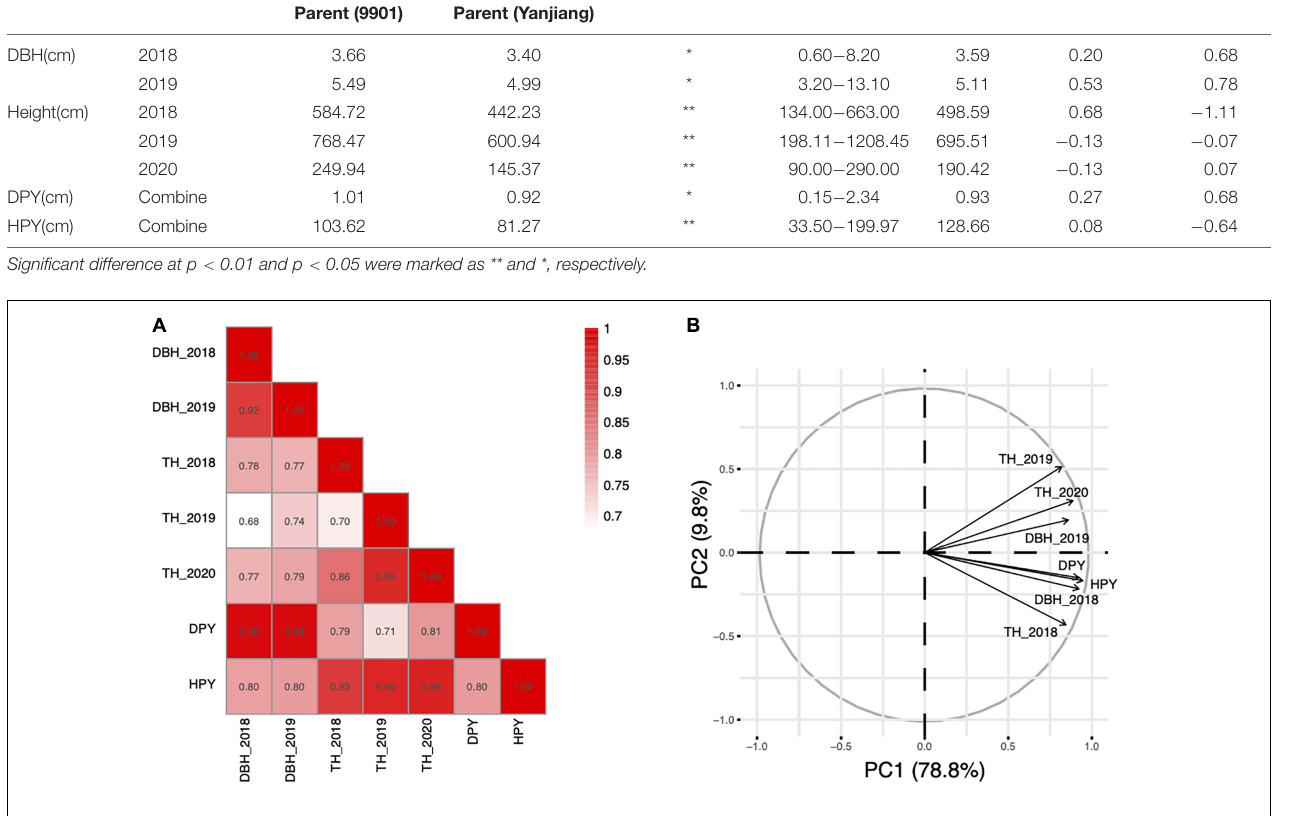
FIGURE 1 | Correlation and PCA analysis among the fast-growing related traits. (A) Correlation analysis among the fast-growing related traits. (B) PCA analysis of the fast-growing related